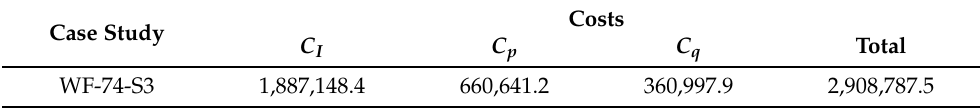
Table 4. Optimal costs: WF-74-S3.